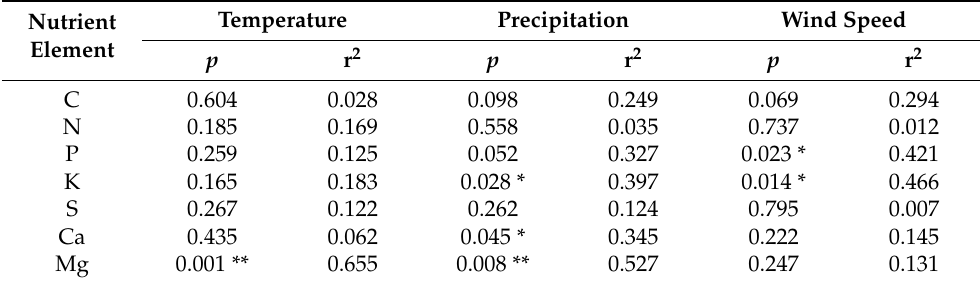
Figure 4. Within ‐ year nutrient return of each element. Table 7. Correlation coefficient between meteorological factors and nutrient Table 7. Correlation coefficient between meteorological factors and nutrient return.